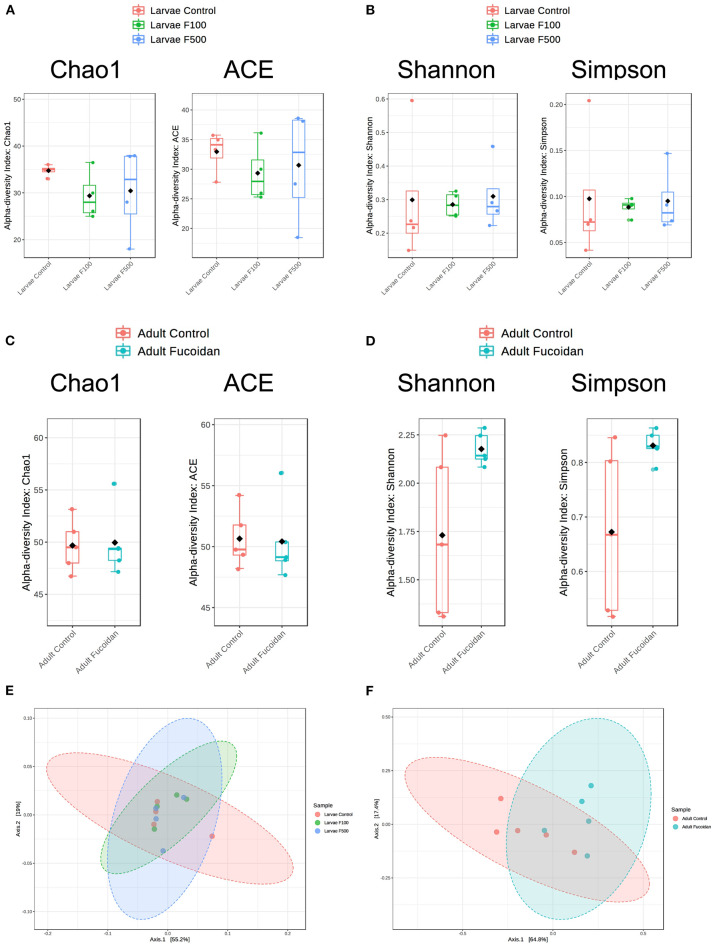
Effect of OM fucoidan on the diversity of larvae zebrafish microbiota and adult zebrafish intestinal microbiota. Species-level community richness (A,C) and species level community evenness (B,D) were compared between larvae zebrafish samples (A, B, E; F100, the zebrafish larvae treated with 100 μg/mL OM fucoidan from 3 dpf for 3 days; F500, the zebrafish larvae treated with 500 μg/mL OM fucoidan from 3 dpf for 3 days) and adult zebrafish intestinal samples (C, D, F; Fucoidan [Tetramin fish flakes: OM fucoidan = 1:1] for 3 weeks). Beta-diversity of larval (E) and adult intestinal (F) microbiota compared by the principal coordinates analyses (PCoA) based on Bray–Curtis dissimilarity index.